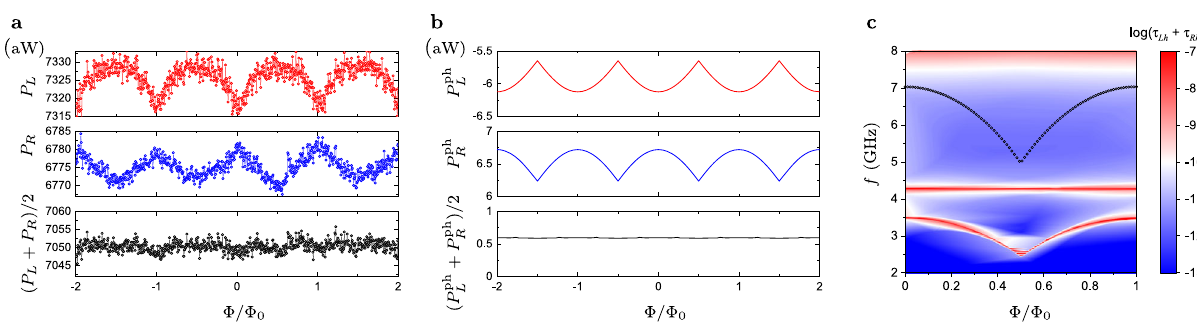
Fig. 6 Modulation of heat powers with heat transport and photon transmission modeling. a Experimentally observed fl ux dependent heat powers dissipated in the left resistor ( P L , red dots), in the right resistor ( P R , blue dots) and the average value ( P L + P R )/2 (black dots). Heating voltage V h = 0.9 mV has been applied to the hot resistor, which resulted in the resistor temperatures T h = 393 mK, T L = 168 mK and T R = 164 mK. The temperature of the mixing chamber was T MXC = 127 mK. b Theory prediction, based on Eqs. (4), (5), for the photonic heat powers dissipated in the left ( P ph L red line) and the right ( P ph R blue line) resistors. Black line in the bottom panel is the average value ð P ph L þ P ph R Þ = 2. We assumed the following resistor temperatures: T h = 393 mK, T L = 176 mK and T R = 156 mK. c The sum of the photon transmission probabilities τ Lh ( ω , Φ ) + τ Rh ( ω , Φ ), given by Eq. (6), assuming the same fi t parameters as in the ( b ). Black circles indicate the double frequency of the three junction loop, 2 ω